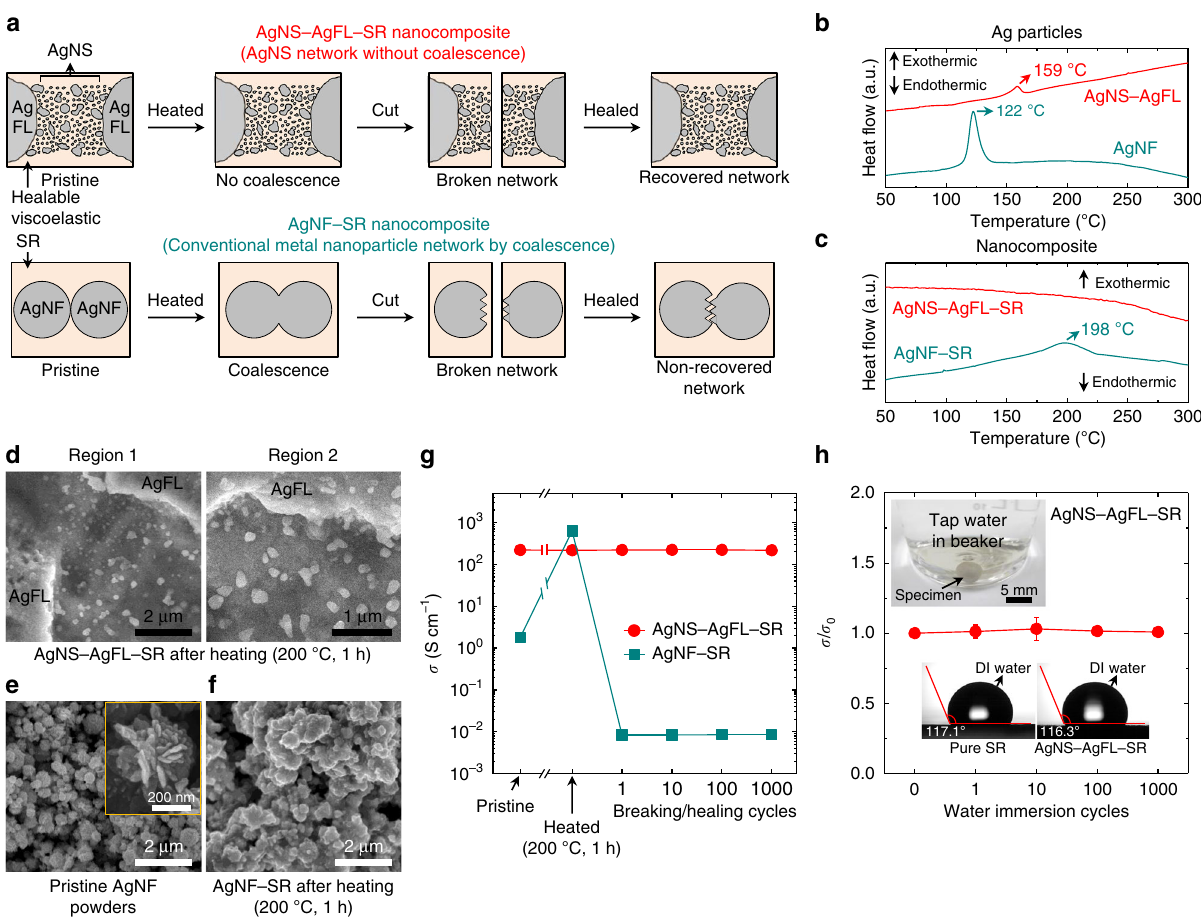
Fig. 5 Electrical network healing mechanism of the AgNS-AgFL-SR nanocomposite. a Schematic of the healing mechanism. Tunneling-assisted, non- coalesced, hierarchically structured AgNS particle network between AgFLs is shown above. Conventional electrical network construction by metal nanoparticle coalescence is shown below. b DSC analysis of AgNS-AgFLs and AgNFs without the SR matrix. c DSC analysis of AgNS-AgFL-SR (Ag = 44 vol %, THF peroxide = 15 mL) and AgNF-SR (AgNF = 20 vol%) nanocomposites. d SEM images of two different regions of the AgNS-AgFL-SR nanocomposite after the heating process (200 °C, 1 h). e, f SEM images of the uncured pristine AgNF powders and cured AgNF-SR nanocomposite (200 °C, 1 h, AgNF = 20 vol%). A magni fi ed SEM image of a pristine AgNF is provided in the inset. g The electrical conductivity of the AgNS-AgFL-SR and AgNF-SR nanocomposites before and after heating (200 °C, 1 h) and subsequent breaking/healing cycles. h The normalized electrical conductivity of the AgNS- AgFL-SR nanocomposite as a function of water immersion cycles. The error bars represent the standard deviation of the data. An optical image of the water immersion process (1 min for each cycle) and water contact angles on the pure SR and AgNS-AgFL-SR specimens are also provided. The conductivity was measured after removing residual water on the